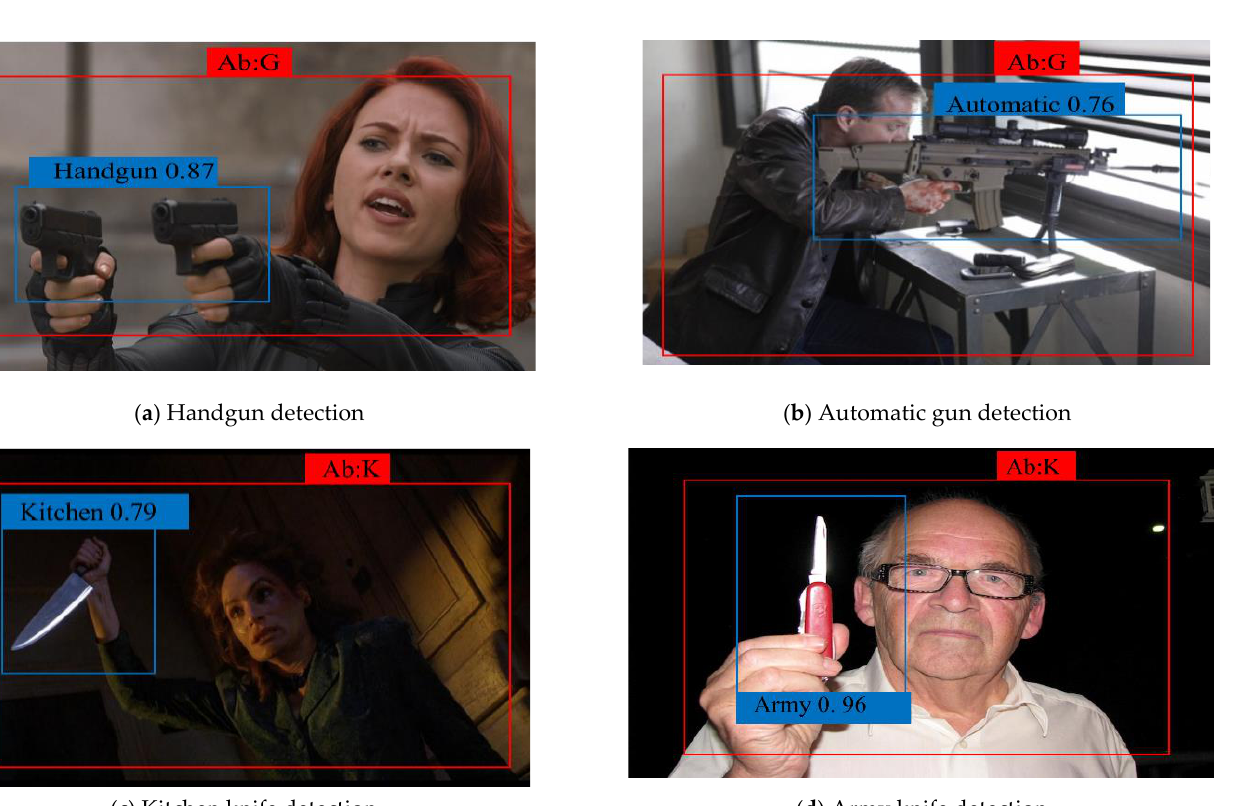
Figure 9. Experimental Training losses of multiclass subclass output classification plotted using matplotlib. They are plotted differently for analysis.